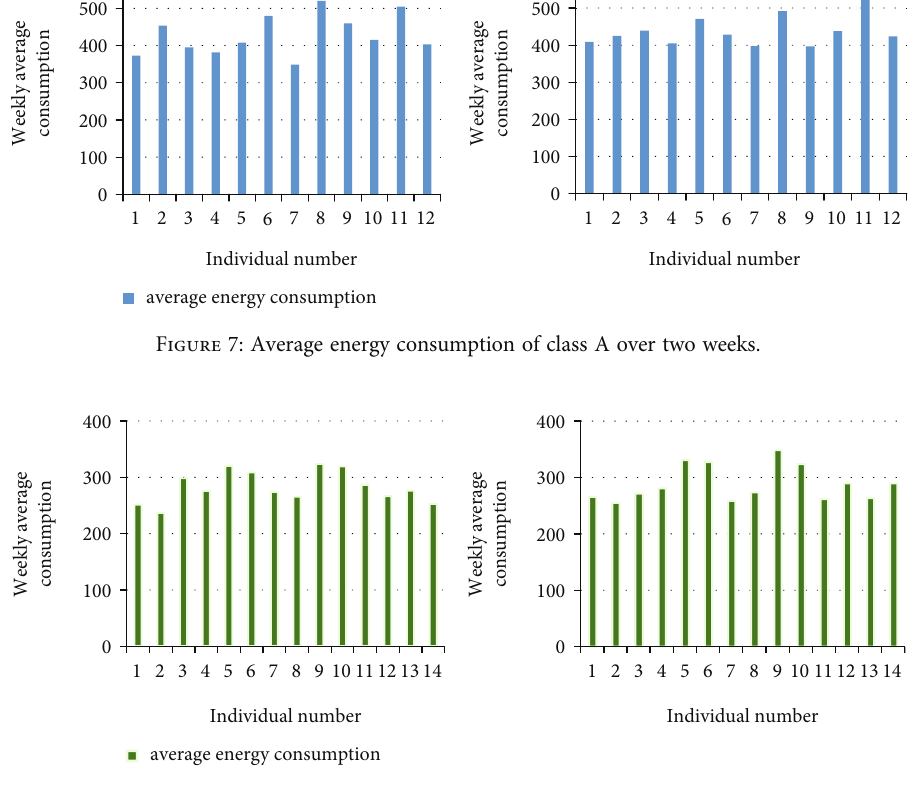
Figure 8: Average energy consumption of class B over two weeks. Table 6: Transfer of average exercise energy expenditure for Table 7: Transfer of average exercise energy expenditure for all everyone in class A in the adjacent two weeks. people in class B in the adjacent two